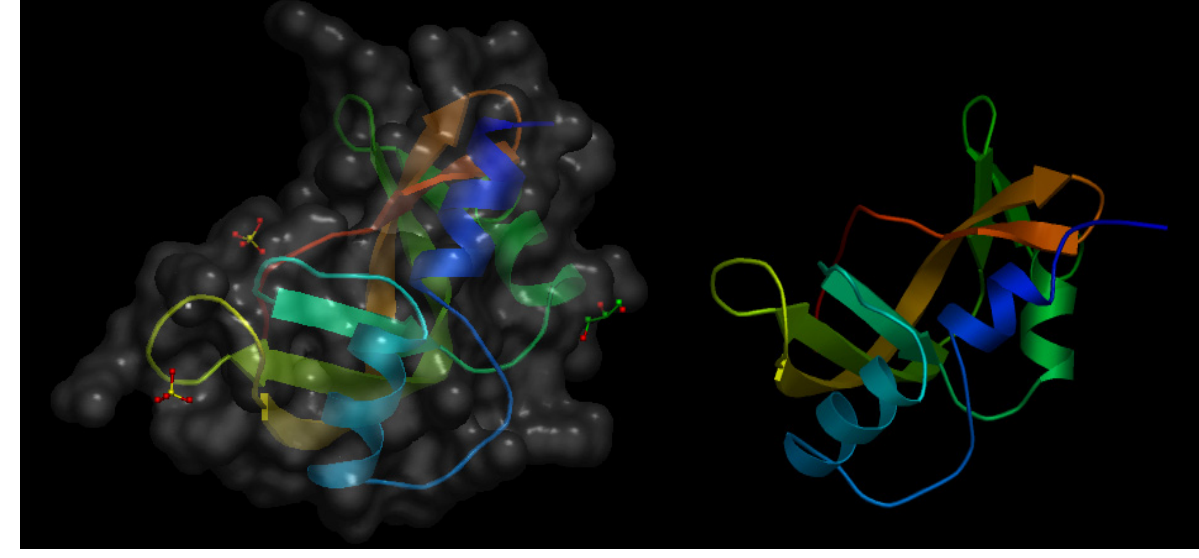
Figure 1. ( Left ) Schematic representation of the crystal structure of murine angiogenin-2 at a resolution of 1.64 Å. The file with pdb ID 3zbv was retrieved from protein data bank [16] and visualized with Open Astex Viewer maintaining the protein on a black background and representing the protein surface in grey with a 30% of opacity. ( Right ) Schematic representation of the available model of bovine angiogenin-2 obtained by homology modeling, based in the crystal structure of bovine angiogenin-1 as a template sharing 58% of sequence identity. The file with psi ID P80929 was retrieved from protein model portal [17] and visualized with Open Astex Viewer maintaining the protein on a black